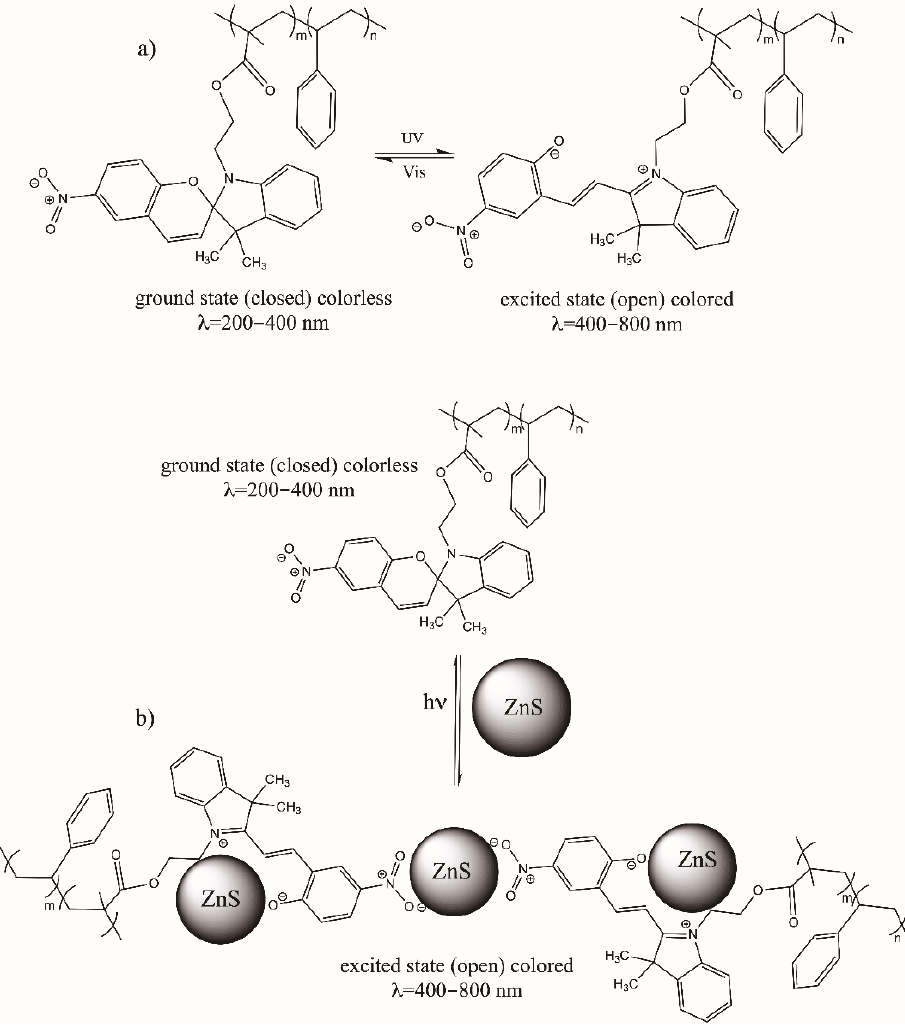
Figure 5. Photochromic reaction of polymer-functionalized irradiated with an ultraviolet light lamp at 365 nm (95 mW/cm 2 ) for 5 min, ( a ) PS- b -PMMA- SP and ( b ) its interaction with ZnS (NPs).